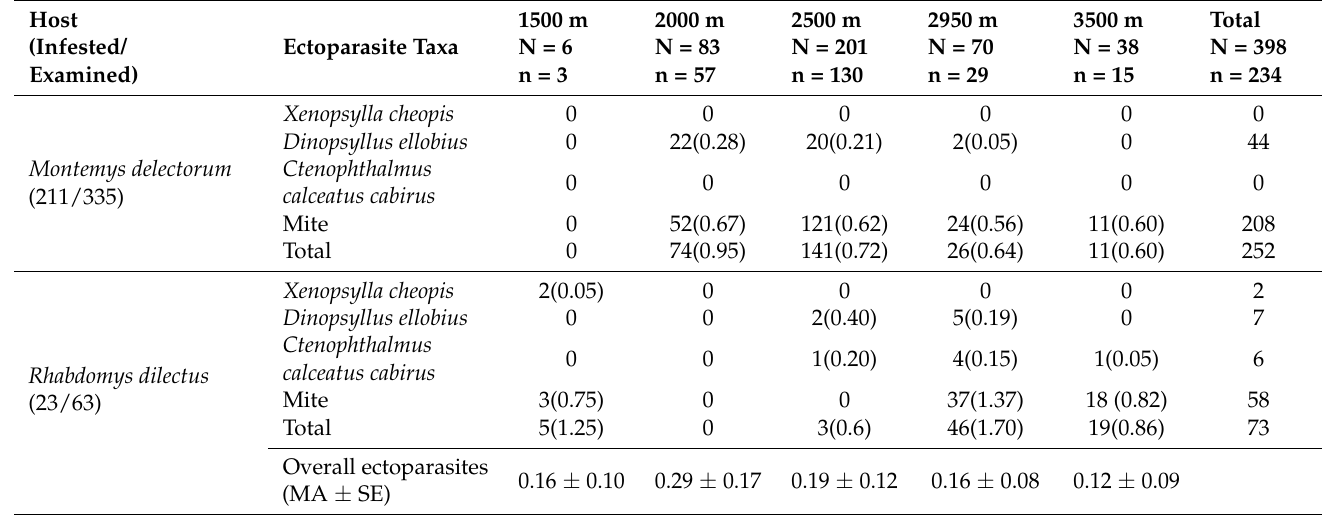
Figure 3. Phylogenetic tree for fleas ( A ) and mites ( B ) using cox2 and cox1 genes, respectively. The evolutionary history was inferred using the maximum likelihood method with bootstrap tests (1000 replicates). The percentage of trees in which the associated taxa clustered together is shown next to the branches. The phylogenetic tree was constructed using the sequences from this study, as well as other reference sequences from GenBank. Tunga and Laelaps were used as outgroup species for fleas and mites, respectively. Table 1. Flea and mite species infecting M. delectorum and R. dilectus at different elevation zones on Mount Meru. N and n are the numbers of hosts examined and infested, respectively. Count and mean abundance of the fleas and mites are provided in